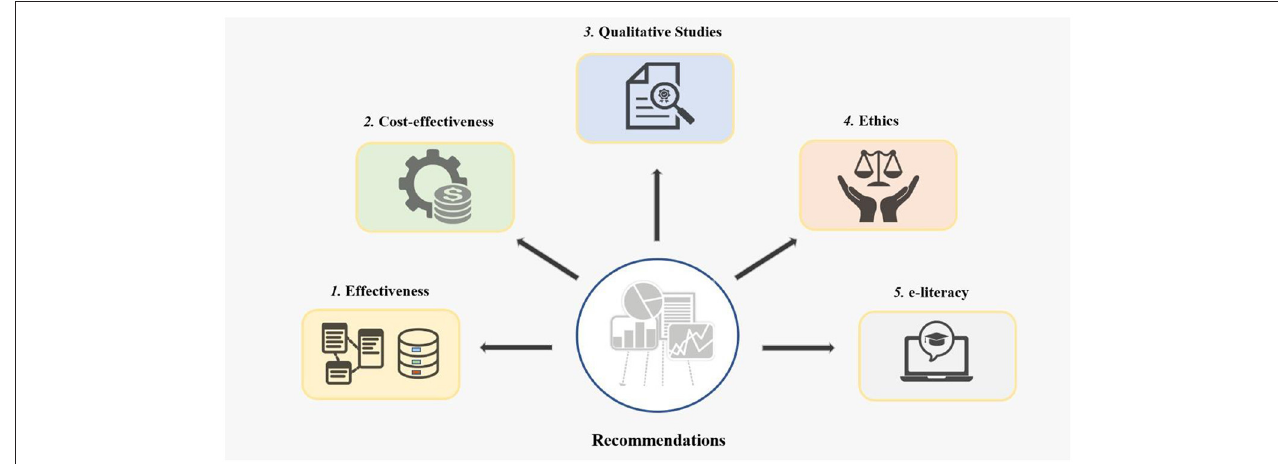
FIGURE 7 | Recommendations to bridge the